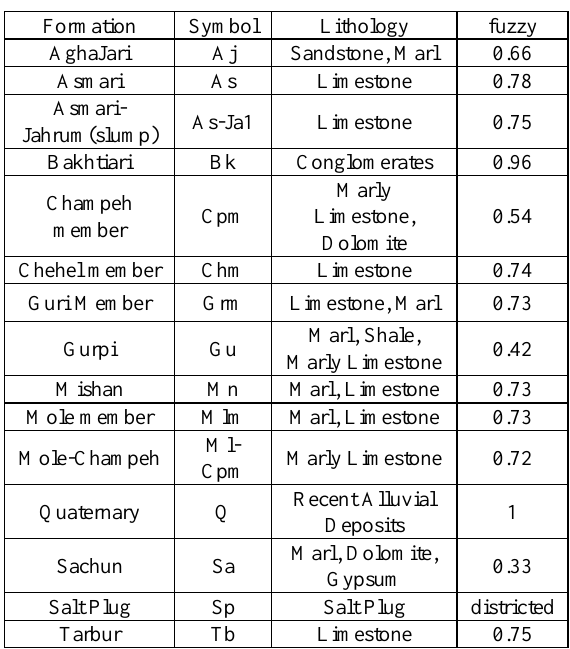
Table 2. Fuzzy membership function for lithology